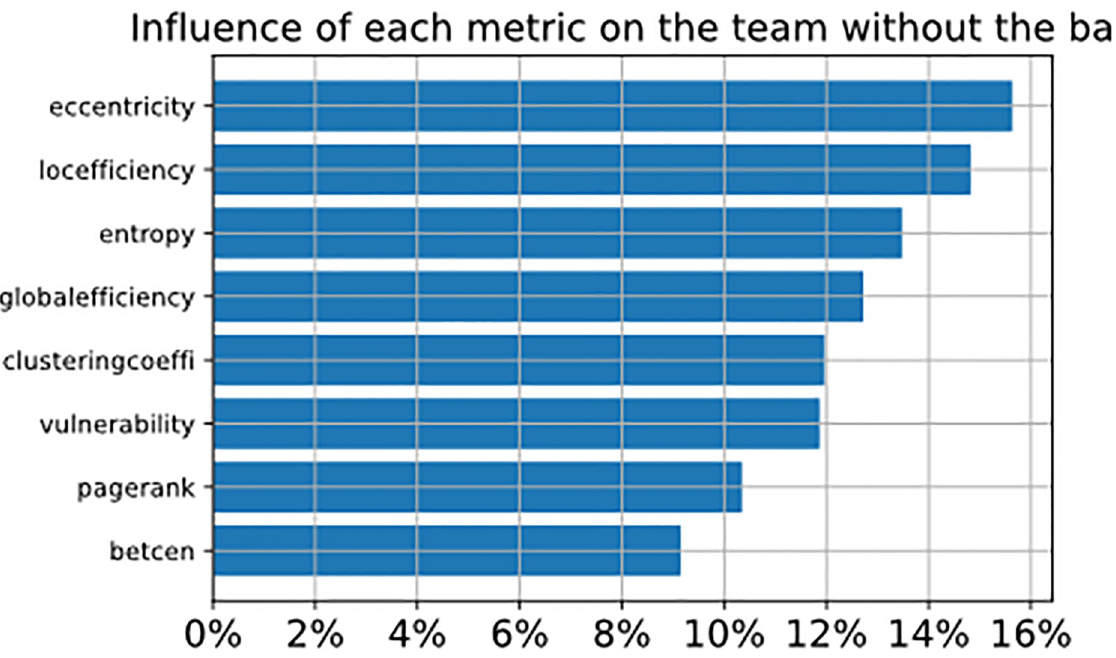
PLOS ONE | https://doi.org/10.1371/journal.pone.0265372 January 18,